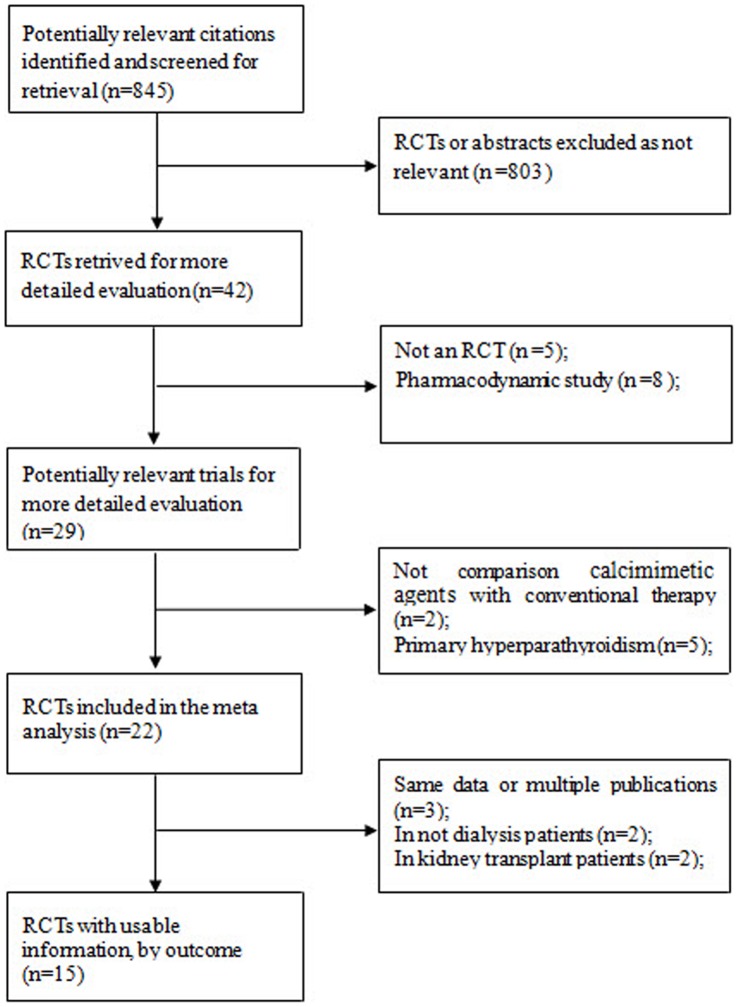
Procedure used for the trial selection.Abbreviation: RCT, randomized controlled trial.